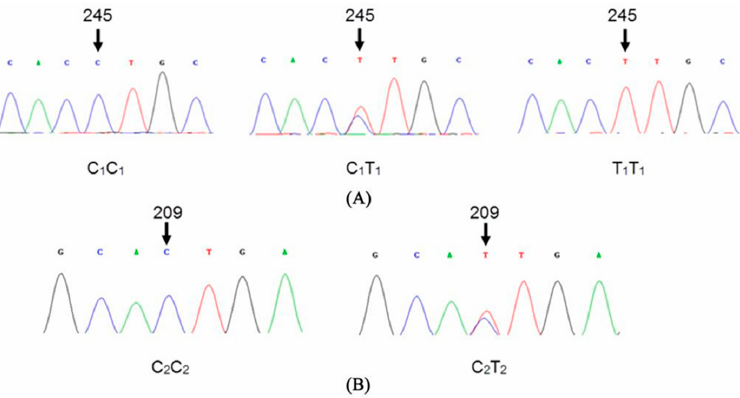
Figure 4. ( A ) Sequence maps of genotypes C 1 C 1 , C 1 T 1 , and T 1 T 1 with g.245 C > T of gene KAP1.4 . ( B ) Sequence maps of genotypes C 2 C 2 and C 2 T 2 with g.209 C > T of gene KAP 1.4 . 3.4. Relative mRNA Expression Level of IGF-1, FGF5, and KAP 1.4 Table 2. Positions of mutations with changes in bases and their effects on amino acids in gene KAP 1.4 of the Northwestern Tibetan cashmere goat.